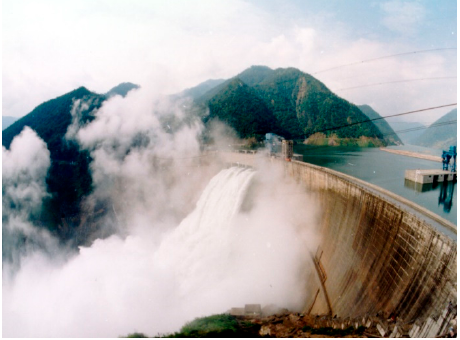
Figure 2. A flood discharge photograph of the Ertan arch dam.